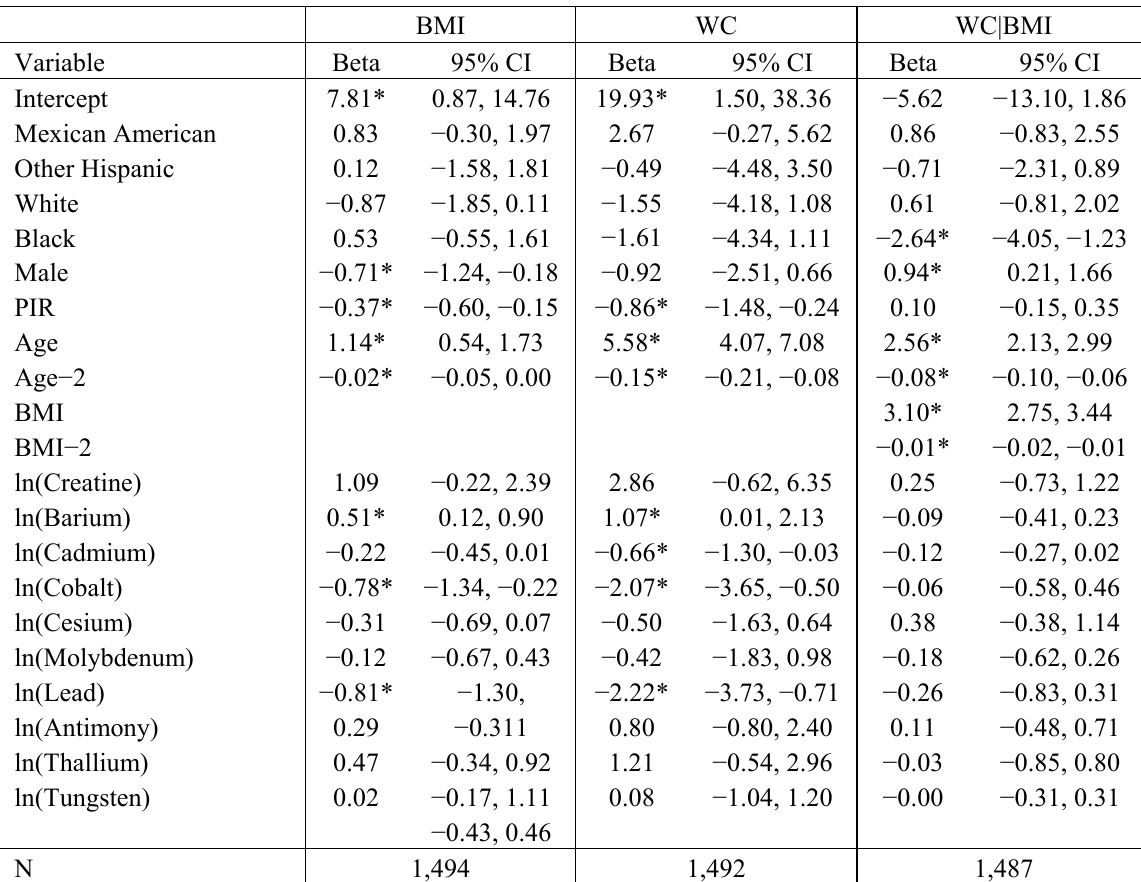
Table 9. Regression Models for